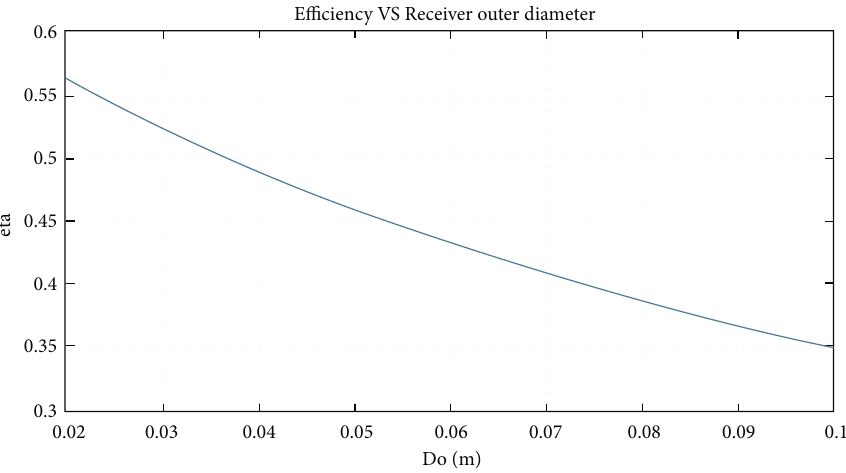
Figure 3: Changes in the e ffi ciency of the absorber pipe by the outer diameter.